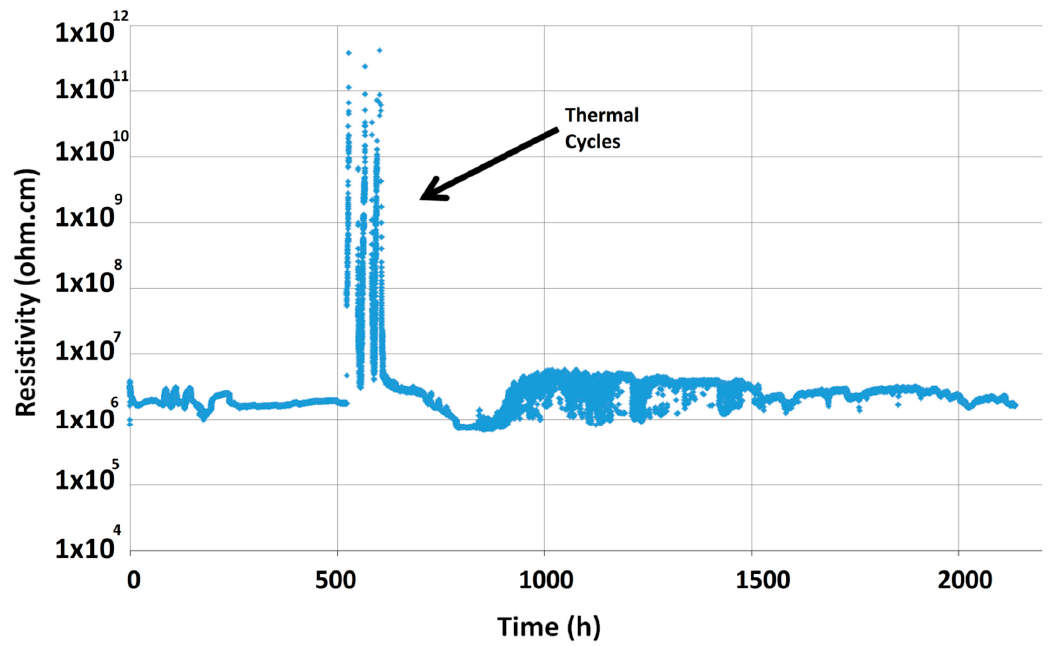
Figure 5. Electrical resistivity of Crofer22APU / HJ28 glass-ceramic / Crofer22APU joined sample, as measured for 2000 h at 850 °C under the applied voltage of 1.6 V.